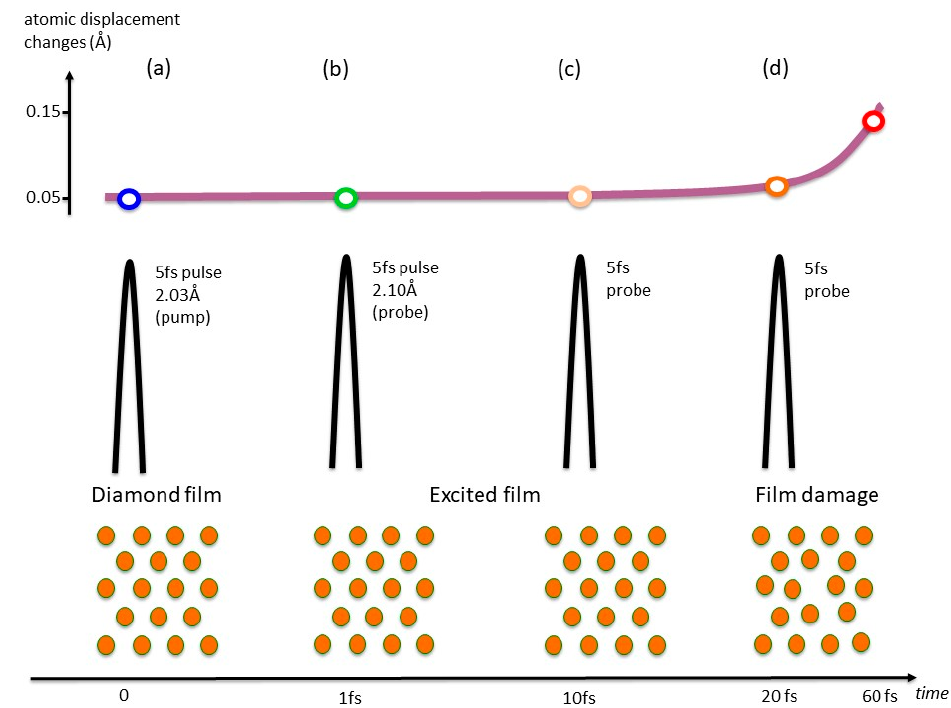
Figure 2. Diagrams with atomic positions and pump-probe pulse structure alongside a graph with the evolution of the atomic displacement changes measured in a diamond film as the pulses traversed the film. Inoue and colleagues [24] determined to what extent a diamond film withstands X-ray radiation before global atomic position changes result in loss of diffracted signal at room temperature. Initially there is a periodic lattice, with the atoms vibrating in their equilibrium positions ( a ). As X-rays traverse the sample, the atomic positions remain virtually unchanged until ca. 20 ps ( b, c ), after which the nuclei start to move to screen the exciton via electron-phonon interaction ( d ). In consequence to the nuclear rearrangement, non-thermal melting and loss of diffraction intensity are observed.